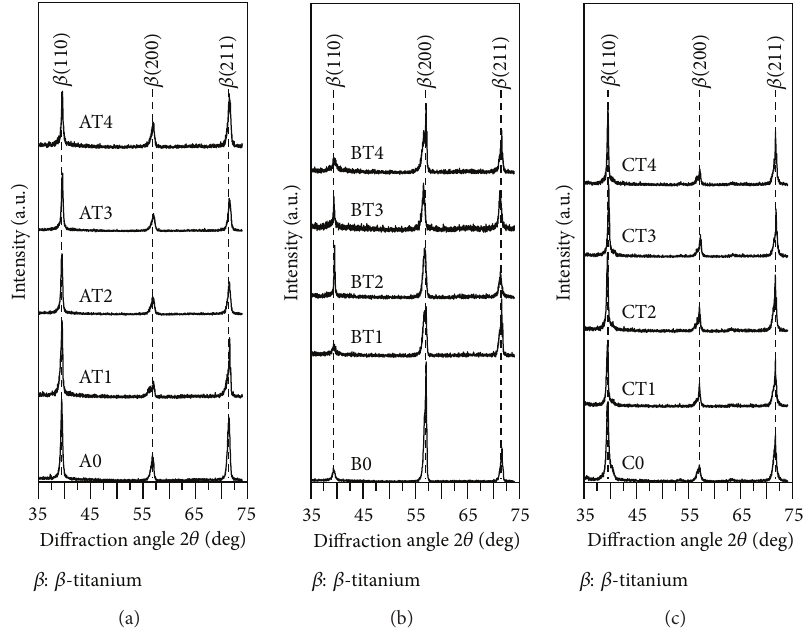
Figure 6: XRD patterns for specimens after cyclic annealing (a) AT l , (b) BT l , and (c) CT l